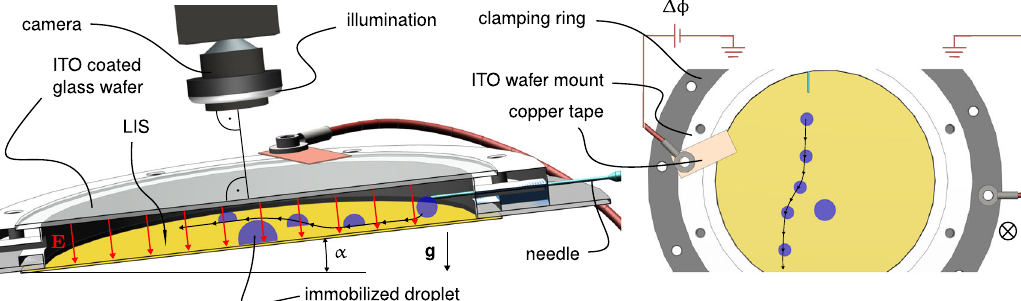
Fig. 1 Experimental setup. On the left-hand side of the fi gure, a schematic of the air- fi lled parallel-plate capacitor containing the droplets is shown. An electric fi eld, visualized by red arrows, is applied between an indium tin oxide (ITO) layer on a transparent fused silica wafer, facing towards the camera, and the bottom side of a lubricant-impregnated silicon wafer. While the immobilized droplet is deposited on the surface prior to the experiments, the mobile droplets are pinched off from a nozzle during the measurements. As indicated by the sketched trajectory (black line), the gravity-driven mobile droplet is repelled from the immobilized droplet due to electrostatic interactions. The trajectories of the droplets are recorded with a camera. On the right- hand side of the fi gure the camera view of a droplet interaction is